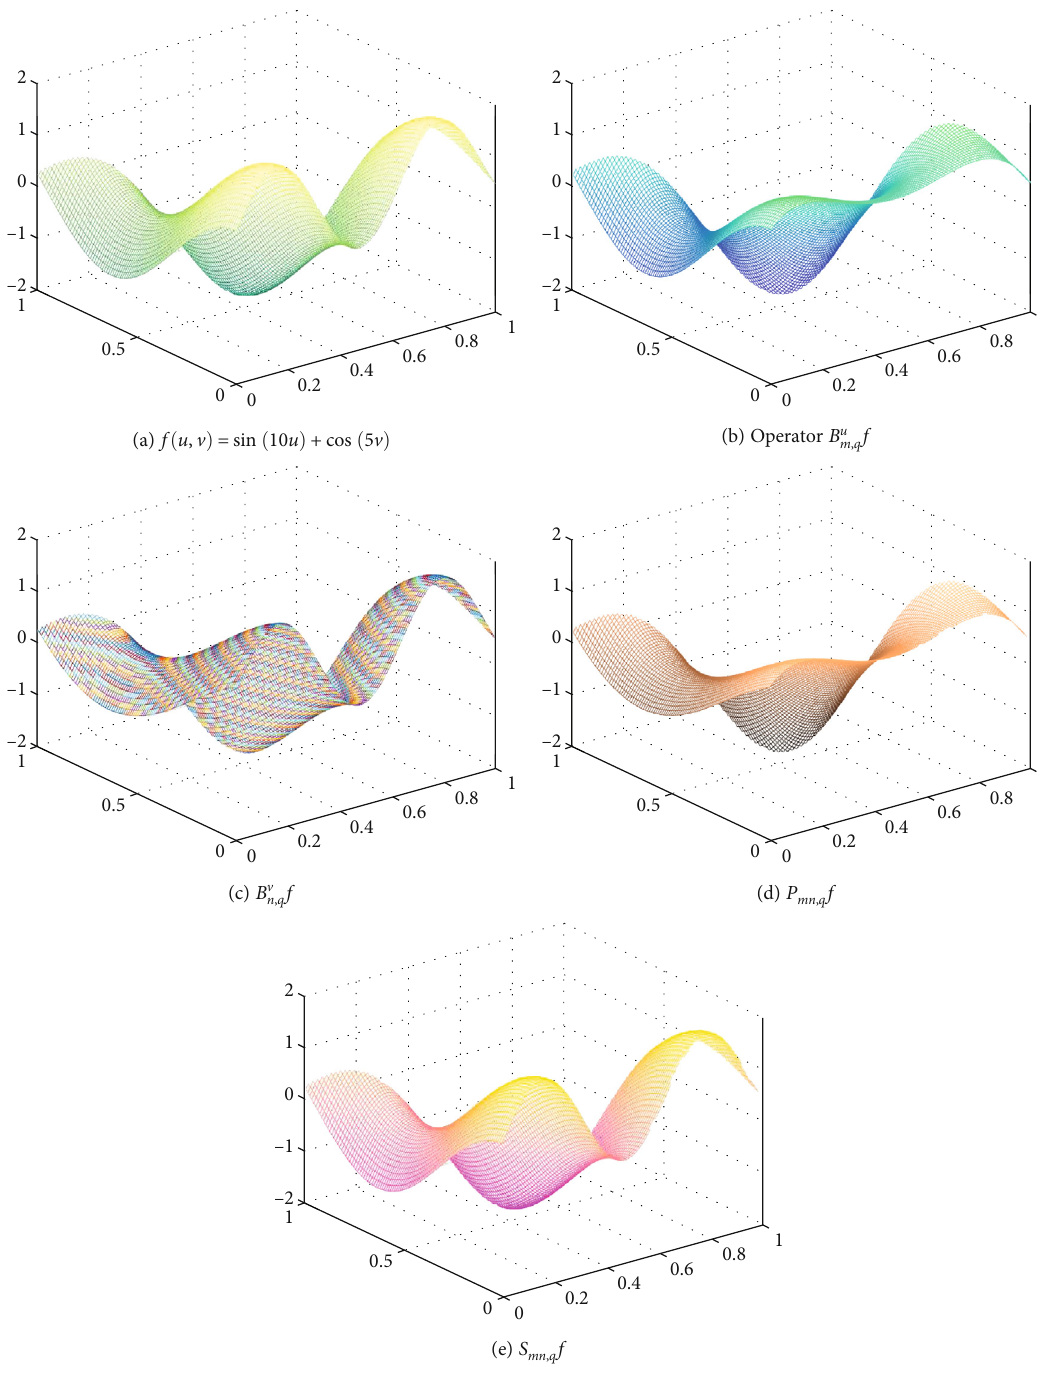
f , B v f , P f , and S f approximating function on triangular domain for h = 1 , m = 6 , n = 6 , and q = 0 : 99 mn , q mn , q m , q n , q